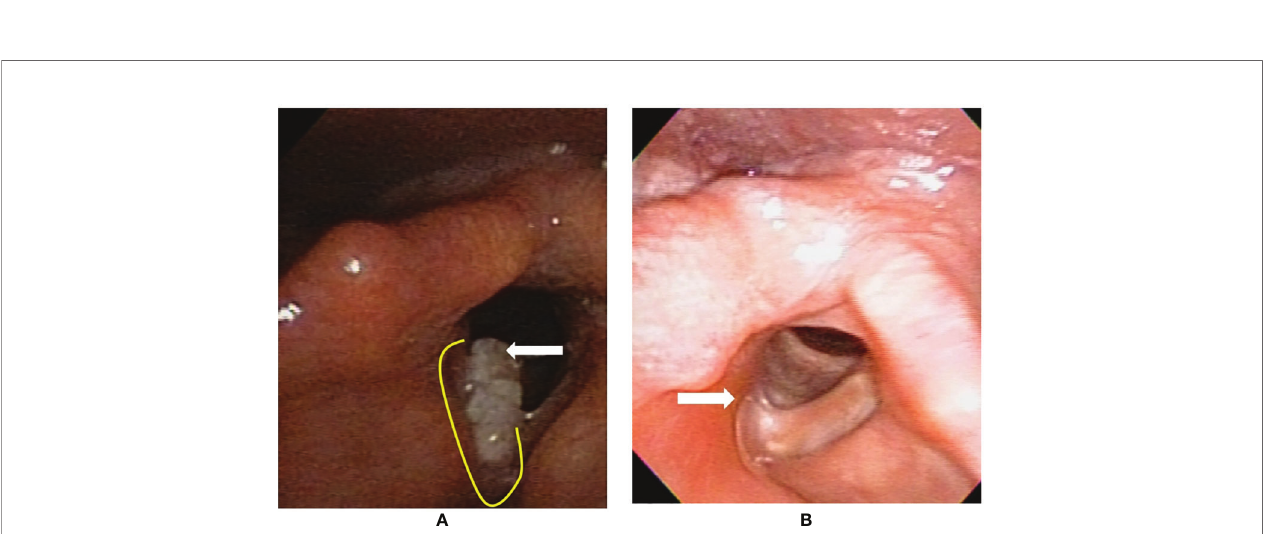
FIGURE 3 | Flexible laryngoscopy view of patient #13 with fresh primary cancer before and after transoral robotic surgery (TORS) type Va+c cordectomy. (A) A cancer (arrow) involving the right vocal fold plus anterior commissure. The yellow line revealed the planned incision line surrounding the tumor. (B) After 25 months from TORS without adjuvant radiotherapy, a fi brotic scar (arrow) formed on the surgical wound bed without tumor